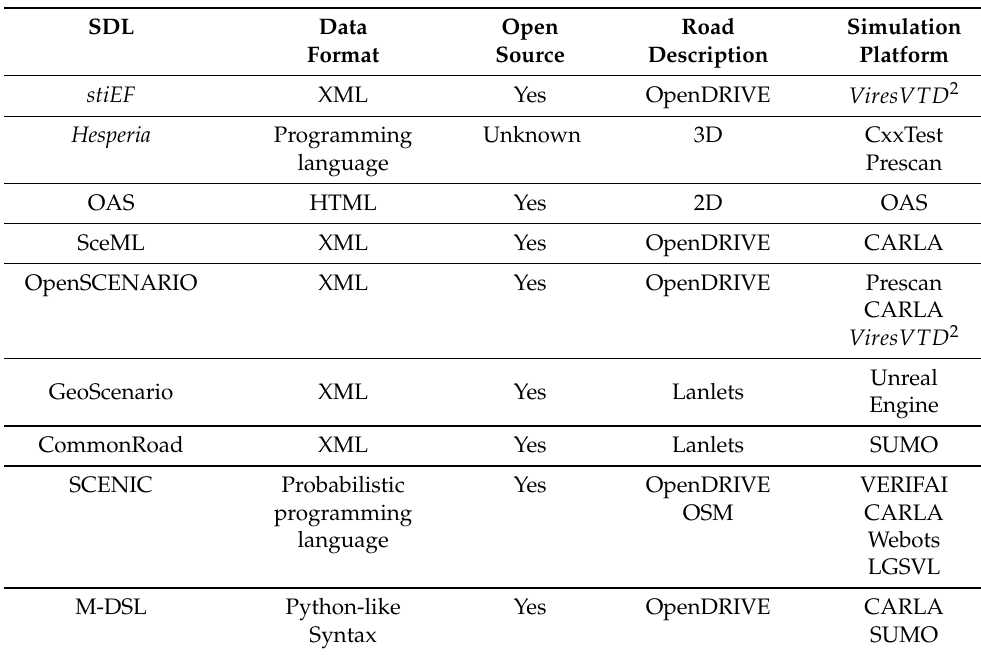
Table 1. Comparison of listed scenario description